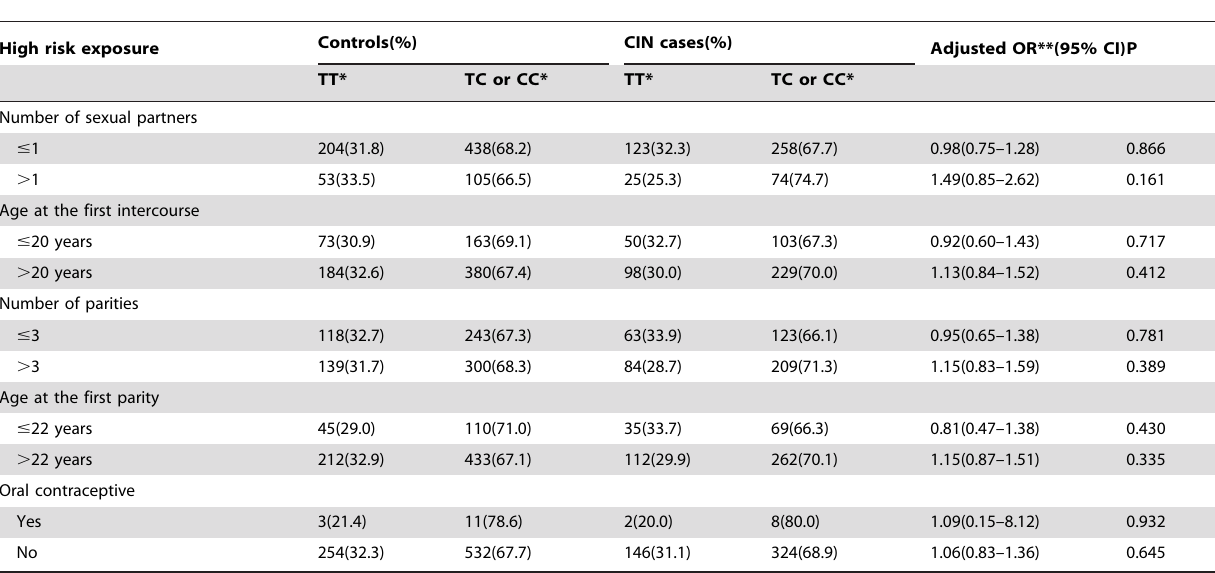
Table 4. According to different sexual or reproductive histories subgroup stratified analyses between the genotypes and CIN risk.